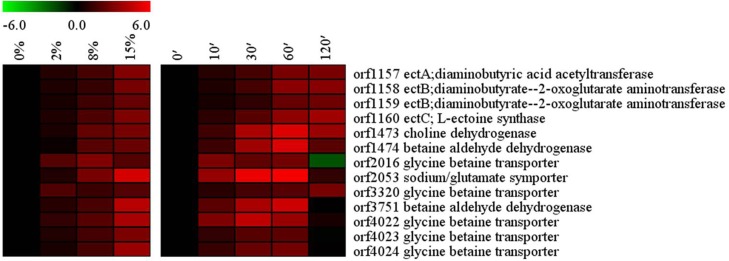
Alterations in compatible solutes related genes.Expression profiles are displayed on the basis of log2 ratios.